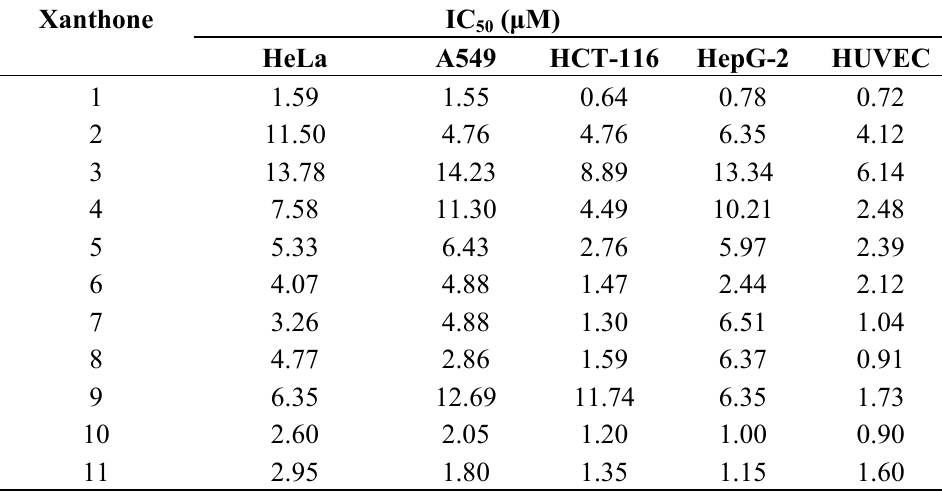
Table 1. Cytotoxicity of caged polyprenylated xanthones 1–11 against four cultured human cancer cell lines and HUVEC cell line in the MTT